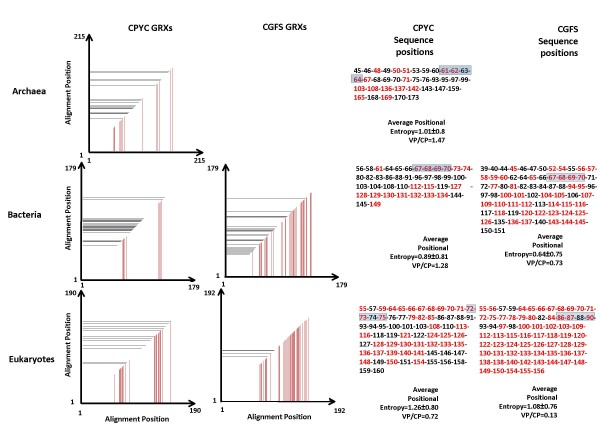
Functional importance of residues in the different position of the alignment. Sequences were divided into two classes (CGFS and CPYC). Then, they were further divided into Archaeal, Bacterial and Eukaryotic sequences. Because archaea only have a small number of GRX proteins of the CGFS class, we show the results for archaea GRXs of the CPYC class only. Subsequently, Normalized Mutual Information (NMI) and Position Entropy were calculated for the different alignments. Vertical red lines in the plots of the first and second column indicate positions in the alignment that are highly conserved. Horizontal black lines in the plots of the first and second columns indicate positions in the alignment that have high NMI with at least one other position. Numbers in columns one and two indicate the position in the alignment. First column – CPYC class GRXs. Second column – CGFS class GRXs. Third and fourth columns – Detailed positions in the alignments that are colored, with the consensus residues found in those alignment positions. The putative active centers are shaded in blue. Average entropy per residue is also shown in columns three and four.